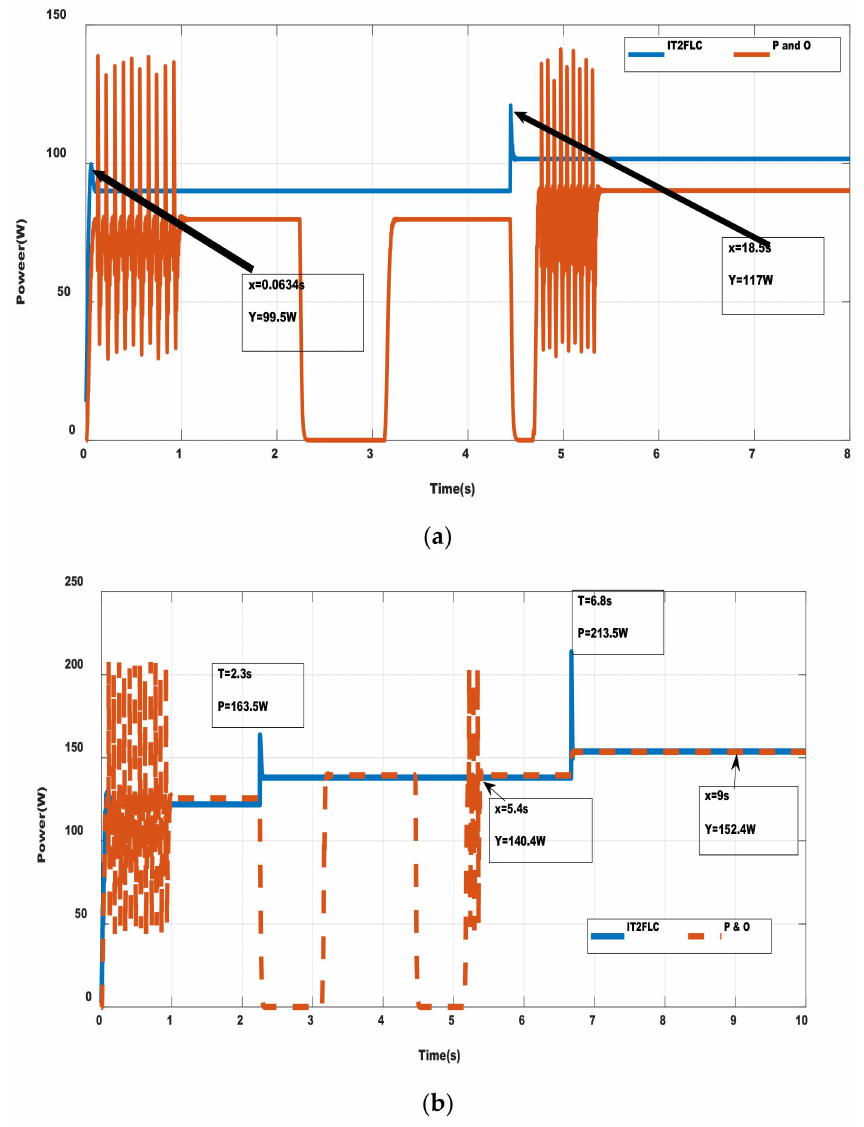
Figure 18. ( a ) Power Response for variable irradiance at 25 ◦ C; ( b ) Power Response for variable irradiance at 25 ◦ C. Table 3. Performance comparison of T2FLC and PO methods for power